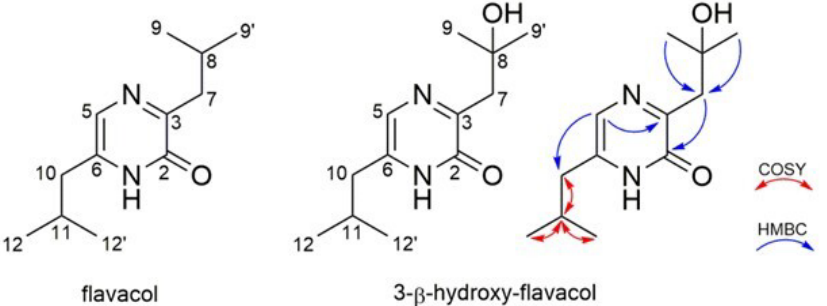
Figure 3. Structure of flavacol and 3- β -hydroxy-flavacol with the key HMBC and COSY correla-